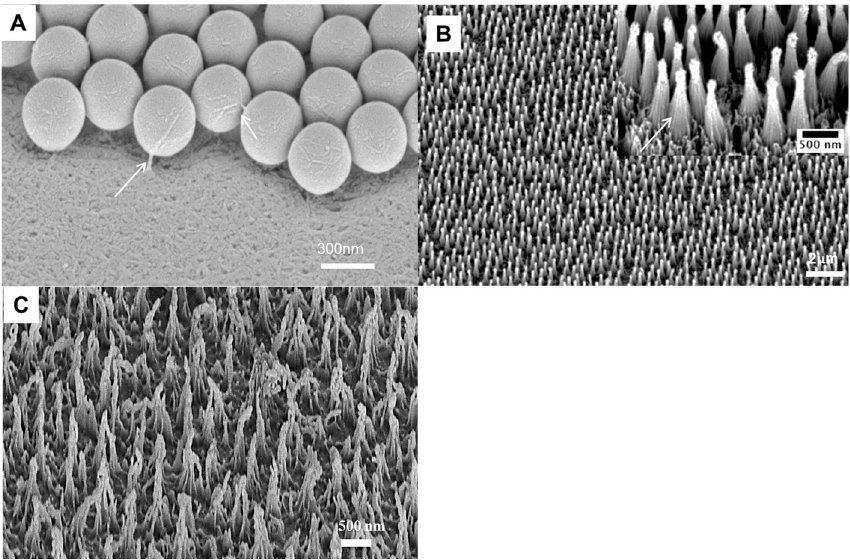
Figure 3. Colloidal/nanosphere lithography on chitin substrate derived from the wing of the periodic 17-year cicada Brood II Magicicada septendecim. ( A ) A nanosphere mask on the chitin substrate. Notice the filaments emanating from the chitin surface to the nanospheres, and the presence of a fibrous network on the nanospheres (as noted by the arrows); ( B ) An array of chitin nanocones after the etching process. The inset shows the presence of longitudinal ridges along the nanocones; ( C ) The array of chitin nanocones after incubation in an aqueous solution; note the loss of organization in the array and the structure of the nanocones.